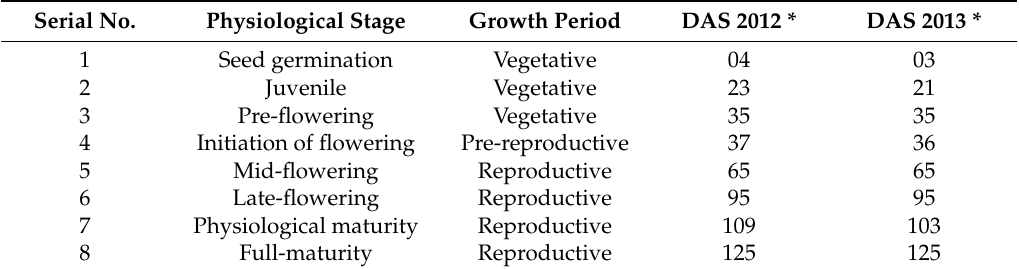
Table 1. Sesame physiological stages and periods were recorded in 2012 and 2013 at PMAS AAU, Rawalpindi, Pakistan by following the descriptions given by Langham